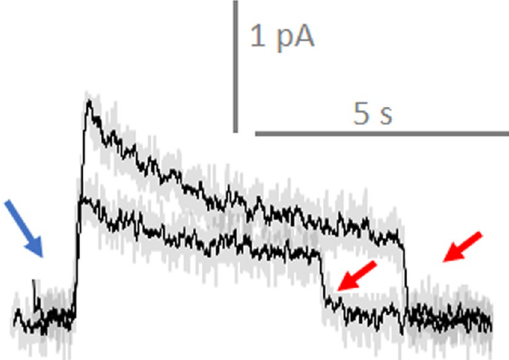
Figure 5. ROS intracellular measurements in individual HEK293 cells. Voltammograms before and after penetration of cells with the nanoelectrode. Voltage is applied vs Ag/AgCl. Representative current traces of a nanoelectrode polarized at + 800 vs Ag/AgCl inside and outside HEK293 cells. Red and blue arrows indicate, respectively, the moment of penetration and retraction. Top graph - ROS intracellular measurements in cells incubated with Magn NP for 3 h in HBSS, lower graph - ROS intracellular measurements in pure cells after 3 h in HBSS. Grey curves are pure records, black curves are records with 100